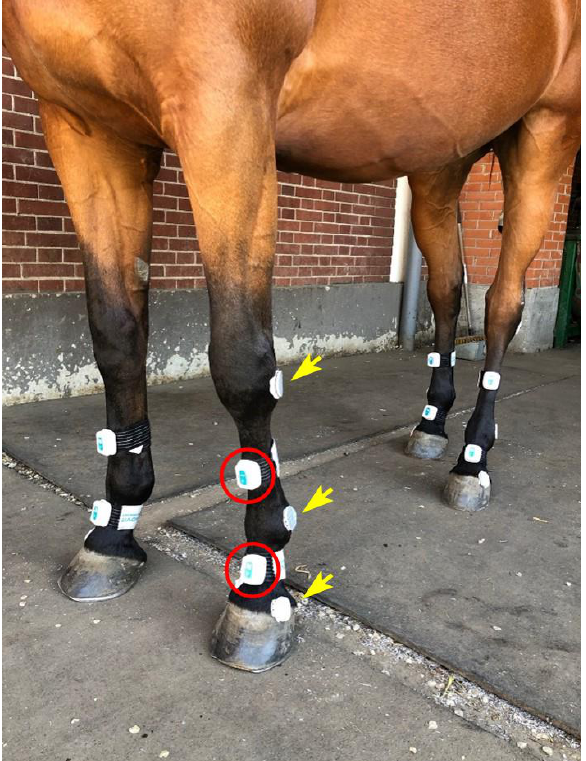
Figure 1. Placement of IMUs (red circle, identified only in one limb) and optical markers (yellow arrows, OMC technology) on equine distal limbs for data acquisition. The IMUs were fixed to the dorsal metacarpus/metatarsus and to the dorsal aspect of the pastern in the four limbs by means of plastic docking bases attached to elastic bands. Optical markers were glued to the skin on the lateral aspect of the joints studied.